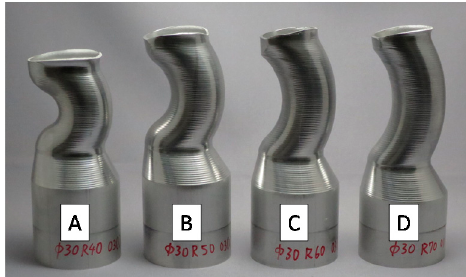
Figure 7. Formed products of samples A, B, C, and D.